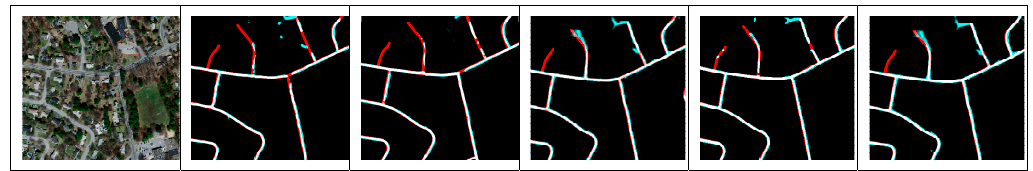
Figure 9. Comparison of the road extraction results of different algorithms in local areas (the small area in the yellow rectangular frame from the image in Figure 8). Table 5. Comparison of the results in Figure 8 with different methods.